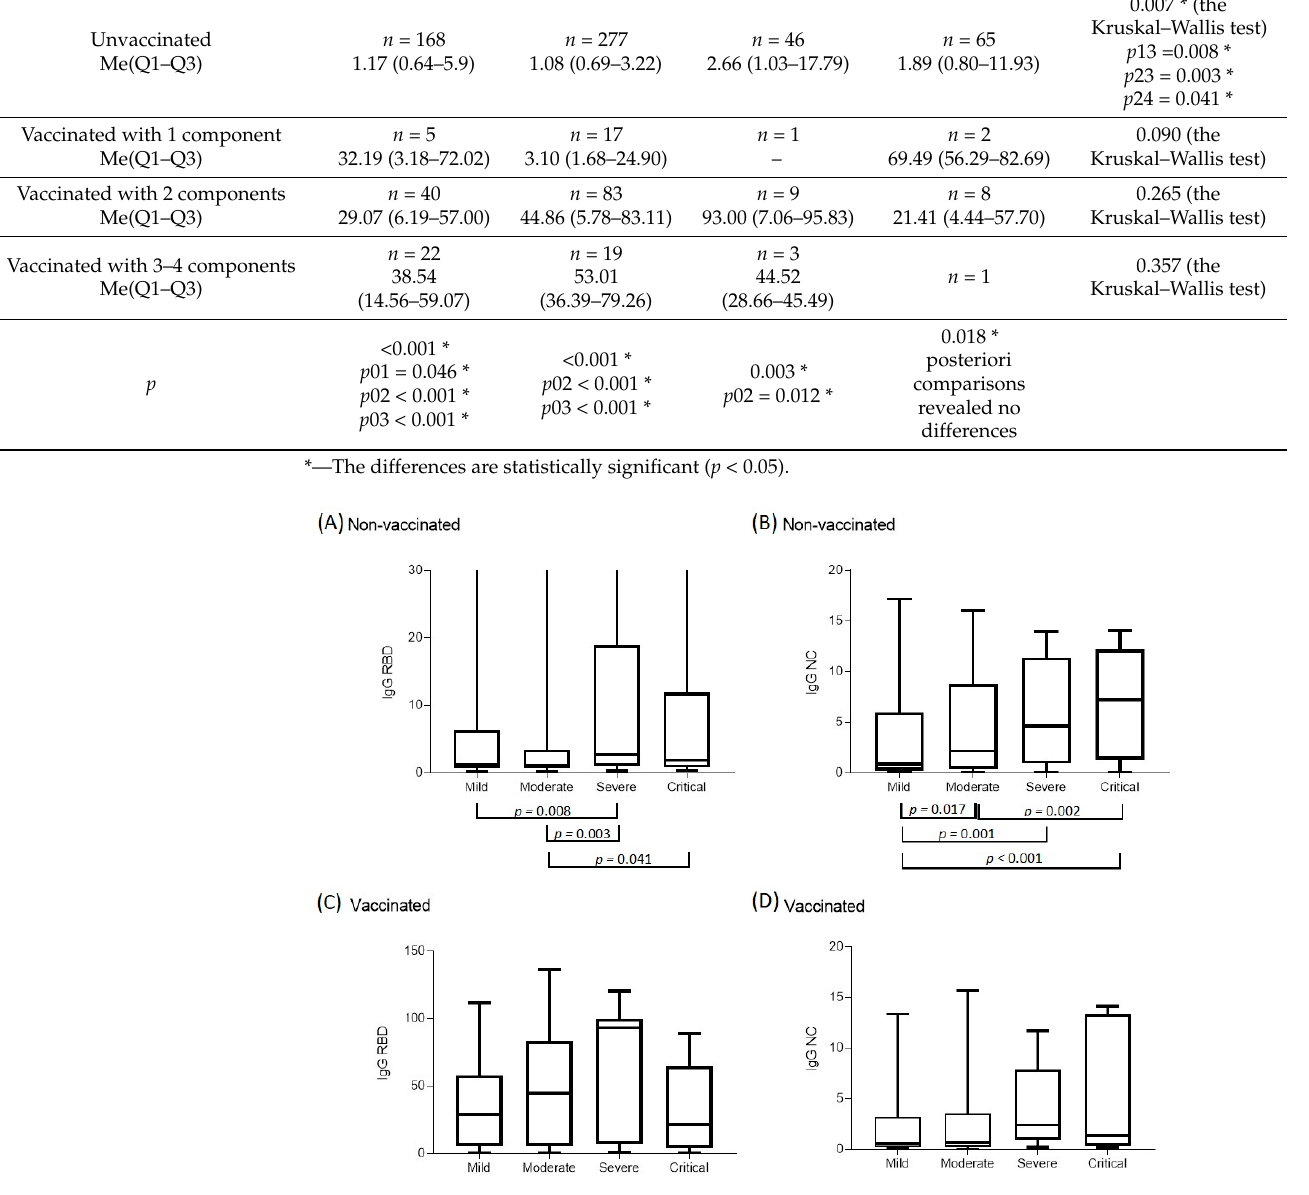
Figure 3. Effectiveness of vaccination in relation to the varying severity of the disease among hospitalized patients, considering the number of vaccine doses received. ( A ) Protection from any cases of hospitalization, ( B ) protection from moderate-severe and more severe cases, ( C ) protection from severe and critical cases, and ( D ) protection from critical cases (VE 95% CI).